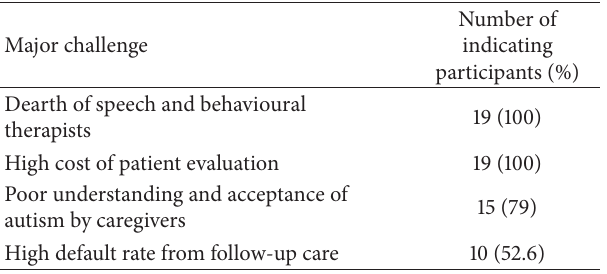
Table 5: Major challenges in the management of autism as indicated by 19